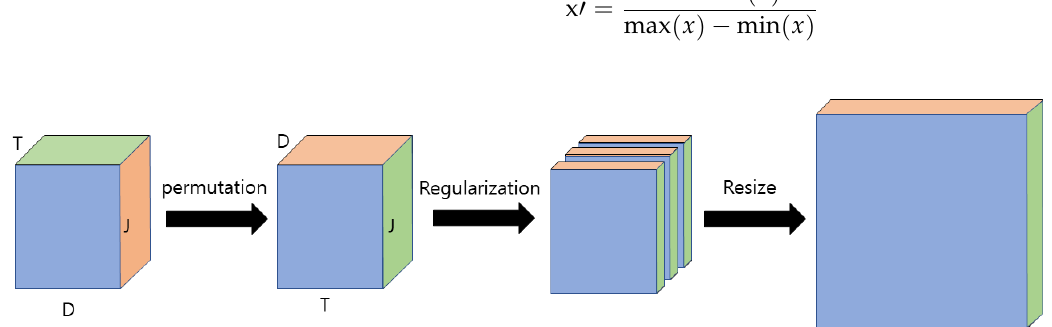
Sensors 2021 , 21 , x FOR PEER REVIEW Figure 1. Schematic diagram of imaging process of a skeleton sequence. Figure 1. Schematic diagram of imaging process of a skeleton sequence.